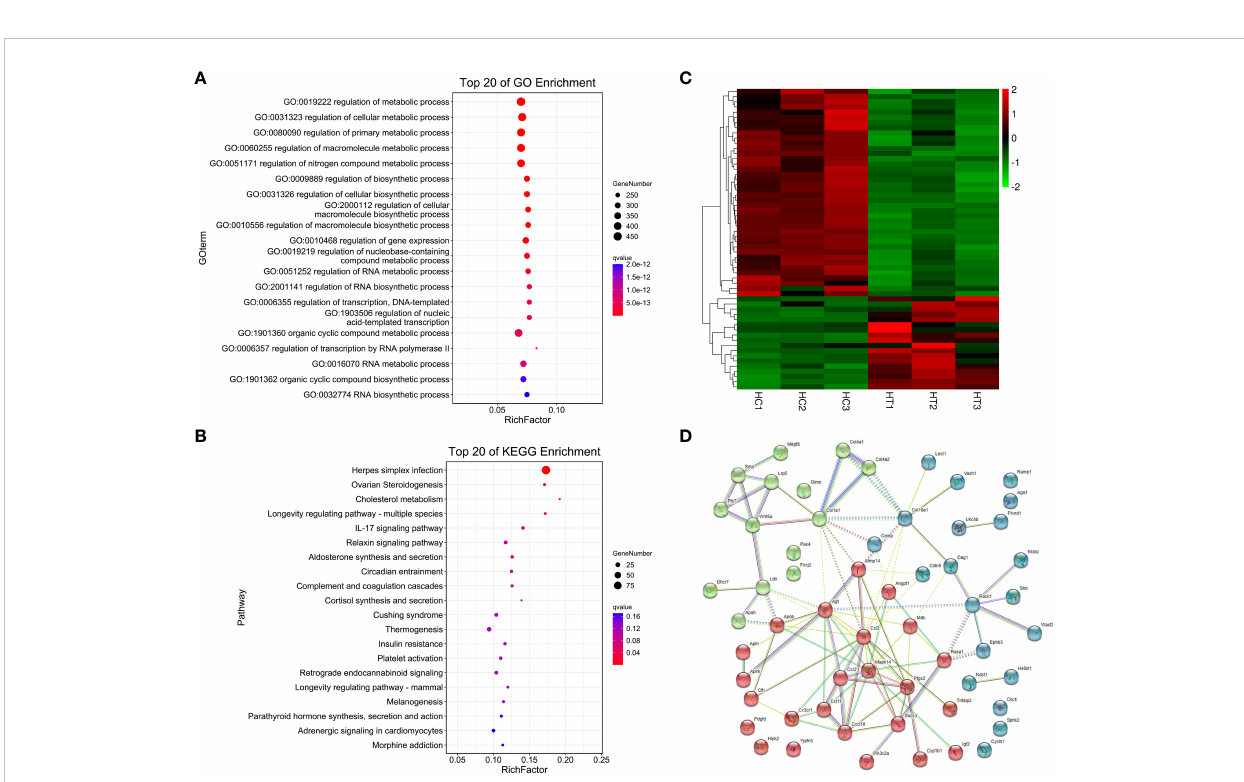
FIGURE 3 Functional enrichment and interaction analysis of DEGs in heart tissue of ART offspring. (A, B) GO and KEGG enrichment analysis of DEGs in the heart (top 20), respectively; (C) heatmap shows the 58 DEGs included in the term “ cardiovascular system development ” ; (D) the interaction of the above 58 DEGs was analyzed by STRING software, and kmeans clustering was performed.